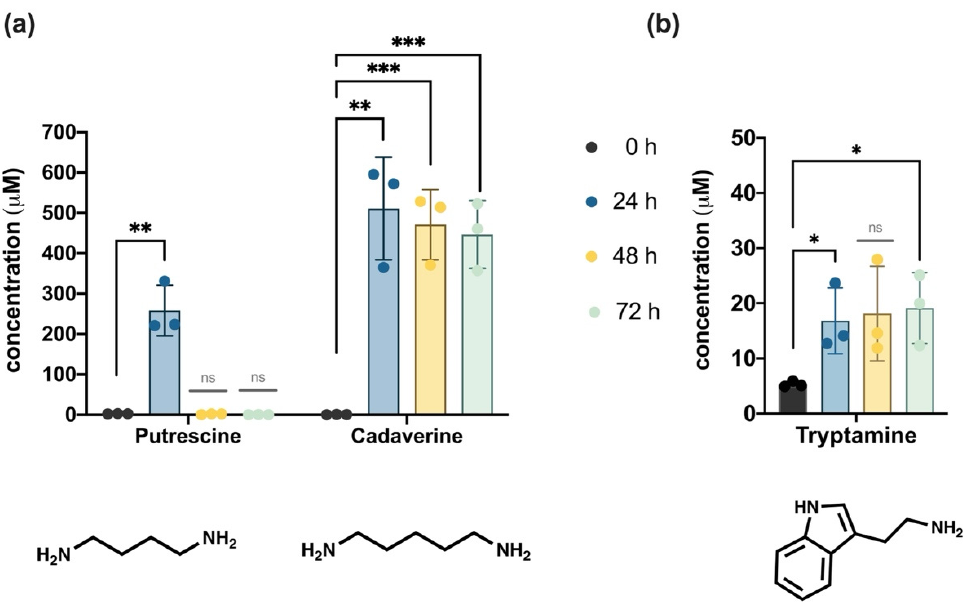
Figure 4. Microbiota-derived production of ( a ) putrescine and cadaverine and ( b ) tryptamine. Data are expressed as mean ± SD. Statistically significant differences evaluated using one-way ANOVA comparisons followed by Bonferroni’s post-test are indicated as p < 0.05 (*), p < 0.01 (**), p < 0.001 (***), and p > 0.05 (ns).